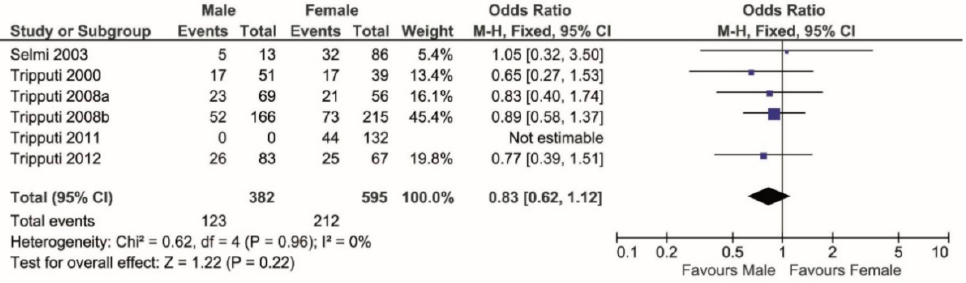
Figure 1. Forest plot comparing the percentage of T/T genotype (events) over the T/T + T/C (total) in males versus females. T/T shows higher frequency in females.